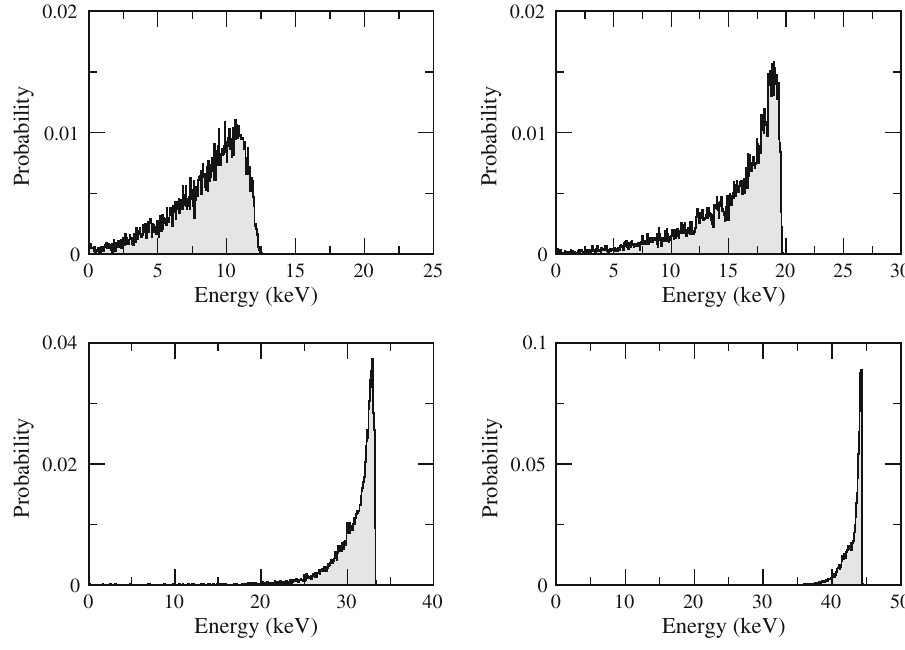
Fig. 5 Plot of CASINO simulated energy distribution of a transmitted electron traversing a single cell of the detector (from Au to substrate) at 25 (upper left), 30 (upper right), 40 (lower left), and 50 keV (lower right). The simulations were done by approximating the graphene/h-BN heterostructure by a 7-nm-thick layer of C, B, and N with a stoichiometric ratio of 2:1:1, and the graphene/MoS 2 photodetector by a 1-nm-thick layer of C, Mo, and S with a stoichiometric ratio of